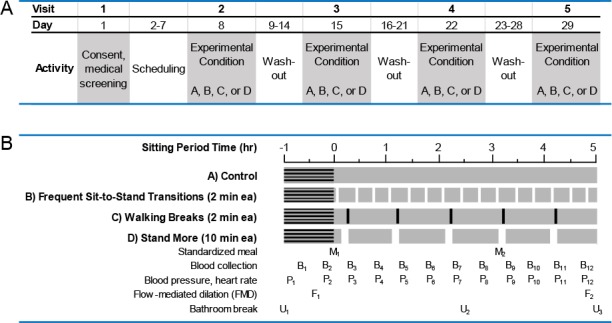
Sitting study design.Panel A. Schedule of participant study visits. Conditions A, B, C, or D were conducted in random order on Visits 2–5. Panel B. Schematic of sitting condition protocols’ activities. Horizontal black lines indicate the 1-hr lead-in sitting phase to achieve steady state. Vertical bars indicate sitting interruption events for respective conditions during the 5-hr sitting period. All conditions (A-D) included a single, per-protocol bathroom break at study period time 2.5hr. Sitting period time “0 hr” occurred immediately following P2 and B2, the moment when the breakfast standardized meal (M1) was initiated. M–standardized meal, B–blood collection, P–blood pressure and heart rate collection, F–FMD study, U–bathroom break.